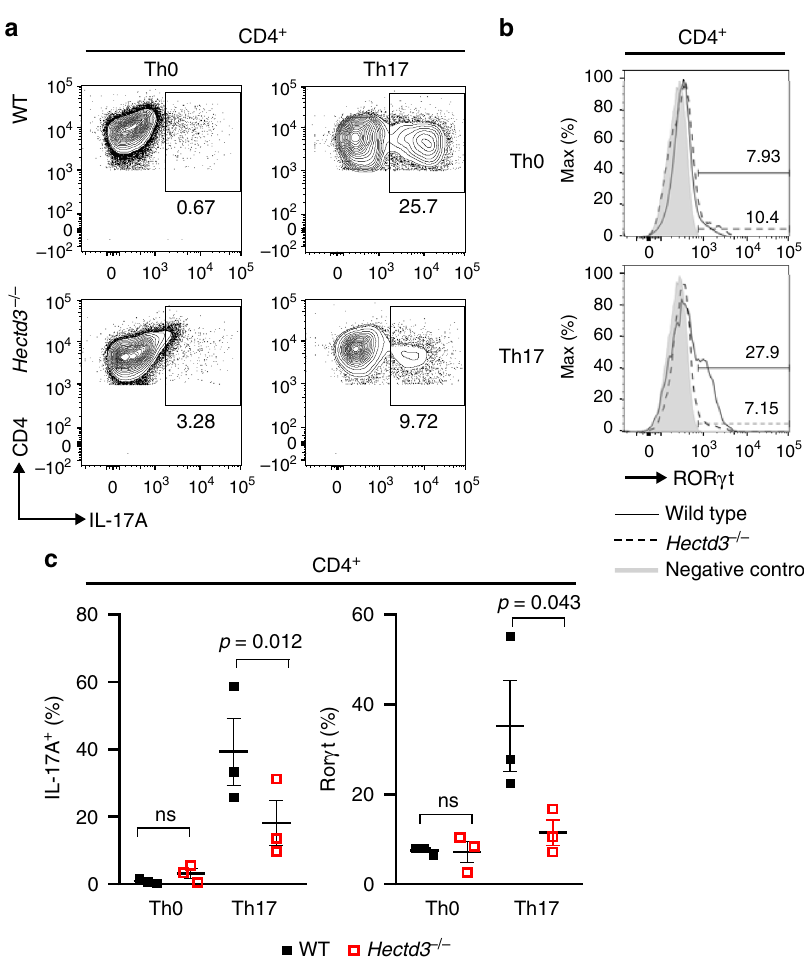
Fig. 1 Defective Th17 polarization of Hectd3-de fi cient CD4 + T cells ex vivo. a Representative fl ow cytometry analysis of intracellular IL-17A from in vitro polarized Hectd3 − / − and wild-type (WT) CD4 + T cells under Th0 or Th17 conditions, n = 3 per group, from three independent experiments. b Representative fl ow cytometry analysis of ROR γ t in in vitro polarized Hectd3 − / − and WT CD4 + T cells under Th0 or Th17 conditions, n = 3 per group, from three independent experiments. Th0 or Th17 conditions are described in Material and methods. c Quanti fi cation of a and b . Data are presented as mean ± SEM; p values were determined using Student ’ s t test. Source data are provided as a Source Data fi le. Gating strategy is shown in